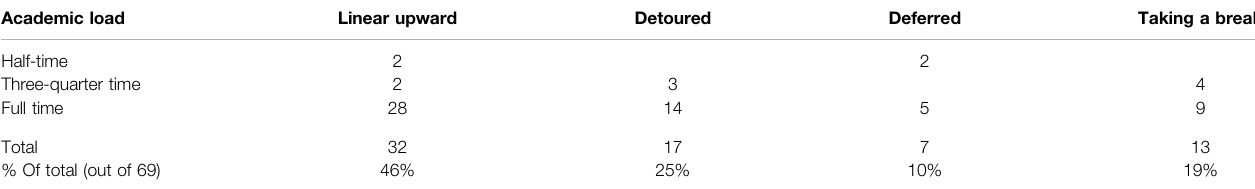
TABLE 6 | Inspire Scholars Program participant momentum trajectories by academic load. Academic